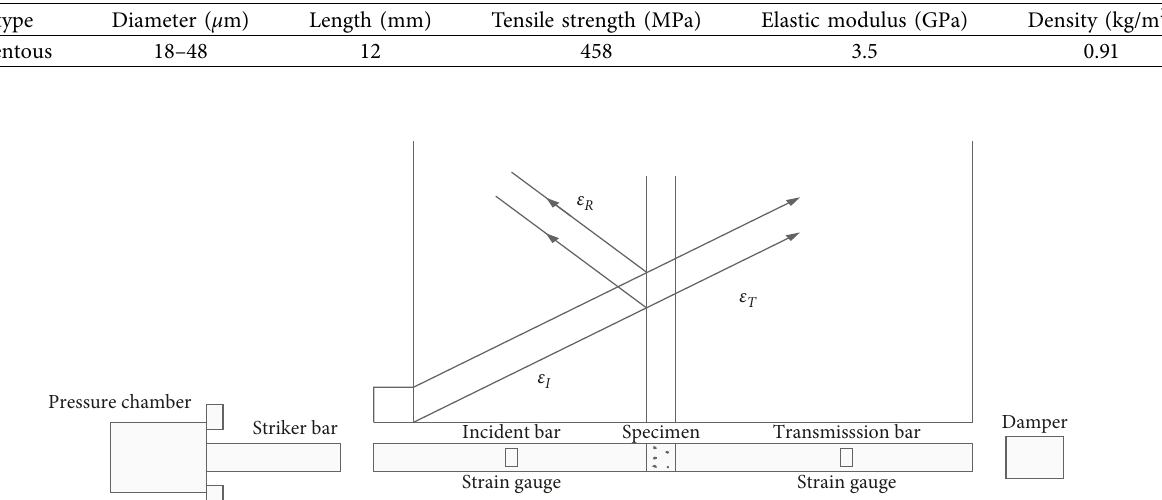
Figure 1: Propagation of stress wave in the bar.